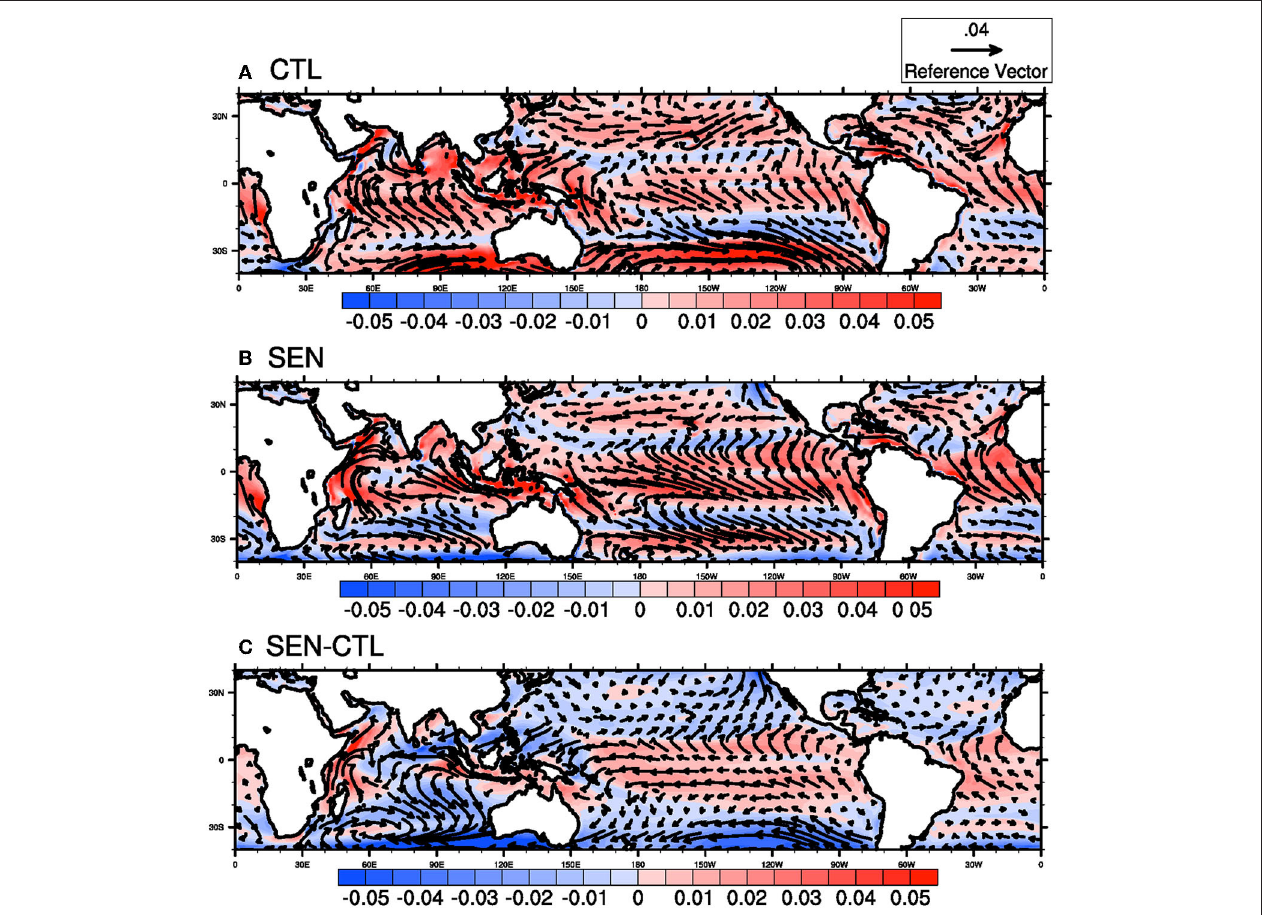
FIGURE 6 | Seasonal (JJAS) mean bias in momentum flux (stress in m2s-2) in (A) CTL run, (B) SEN run, and (C) SEN-CTL for the period of 1981–2017. The colored shading represents the magnitude of stress and zonal and meridional components are represented as vectors.